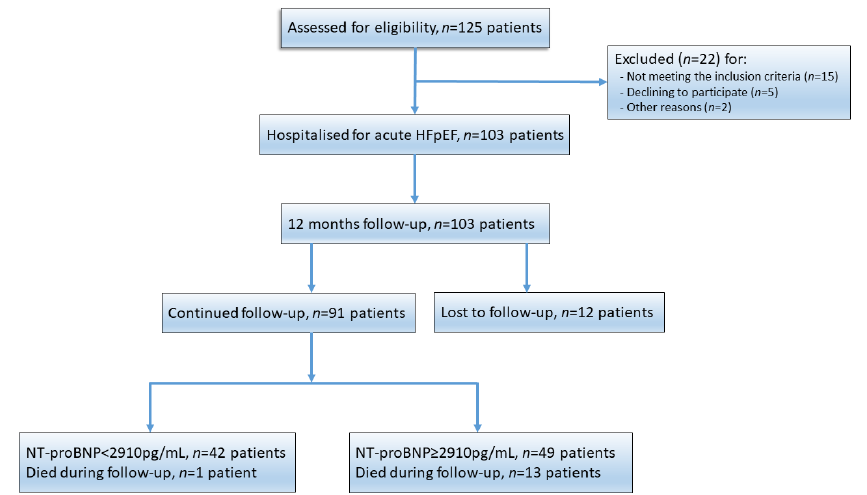
Figure 1. Flowchart of the study.